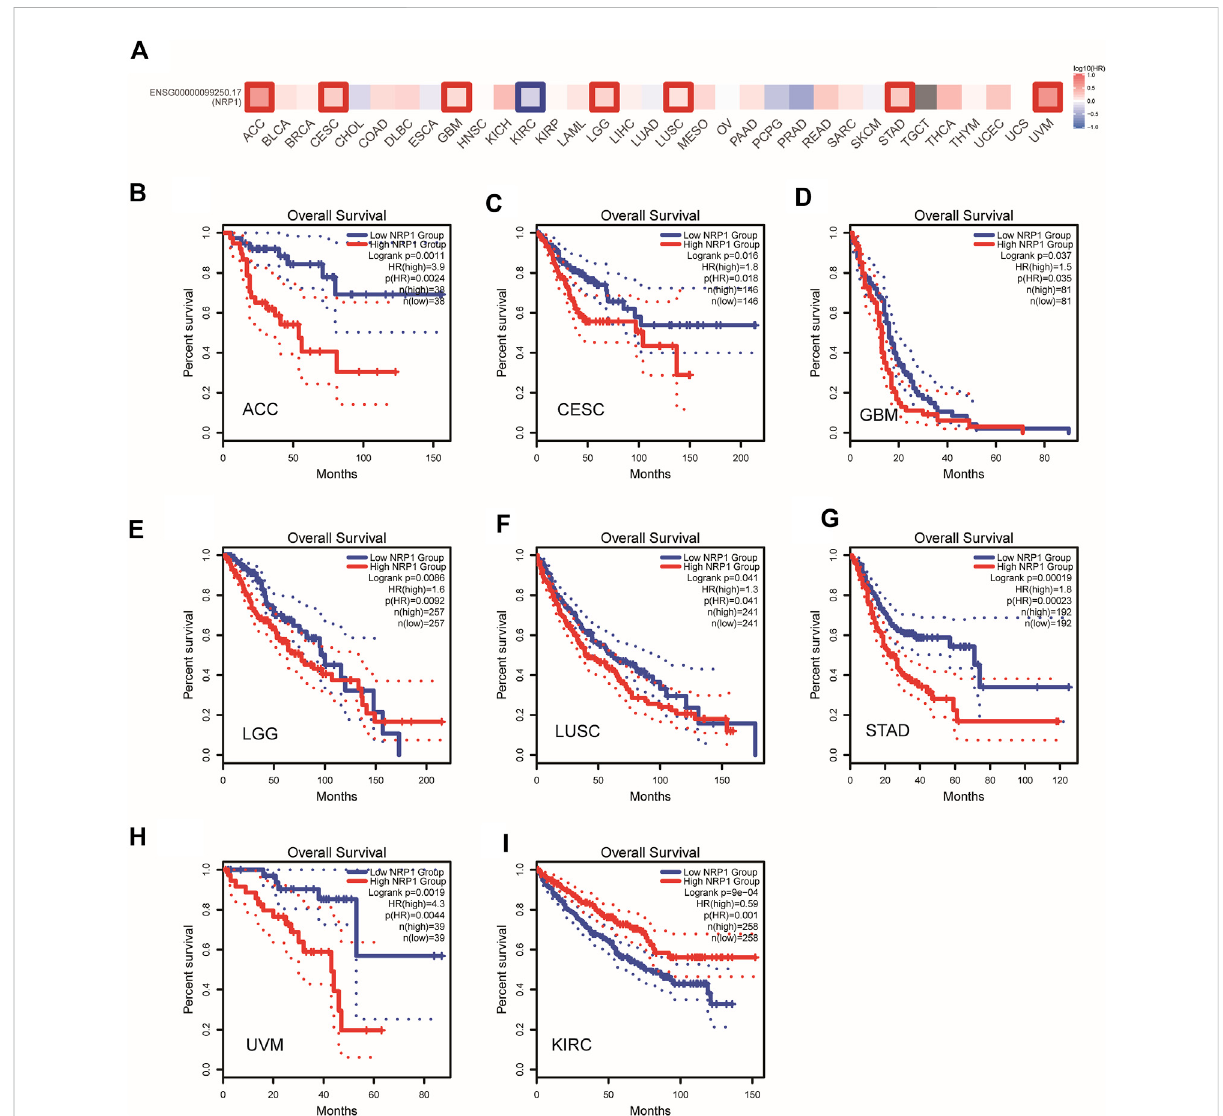
Apan-cancercorrelationanalysisbetweenNRP1expressionandOS (A) AnoverviewofcorrelationbetweenNRP1expressionandOSinmultiple cancer types. The red and blue blocks denoted higher and lower risks, respectively. (B – I) Kaplan-Meier plots of OS in the low NRP1 group and the high NRP1 group in ACC, CESC, GBM, LGG, LUSC, STAD, UVM, and KIRC, respectively. Dotted lines represent 95% con fi dence interval